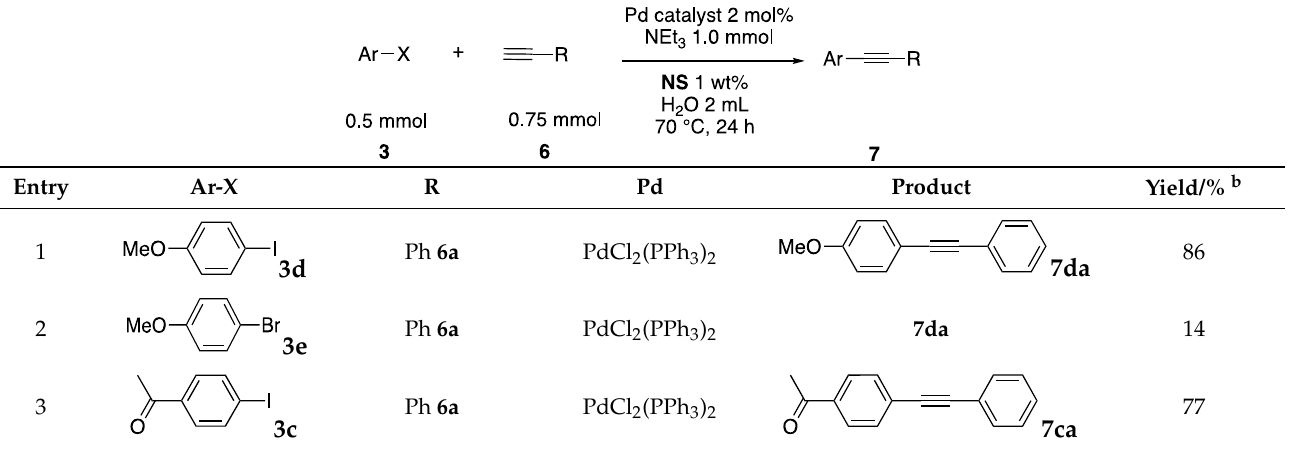
Table 7. Copper-free Sonogashira coupling in water using thermoresponsive copolymers a .